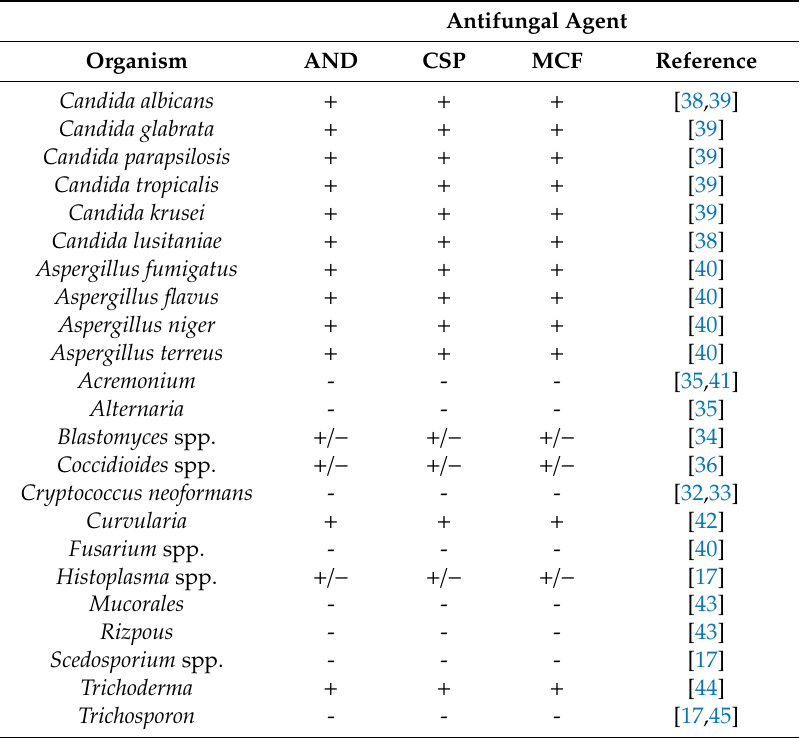
Table 2. Spectrum of activity against common